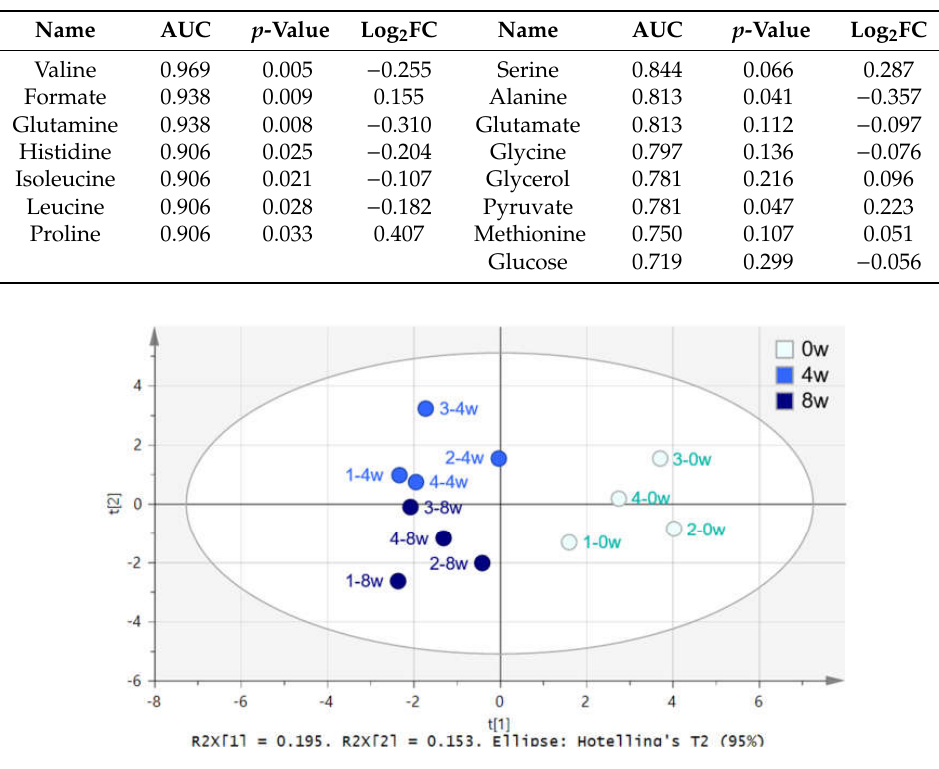
Figure 4. PLS-DA score plot of dog serum 0 ( ● ), 4 ( ● ), and 8 ( ● ) weeks after feeding of black ginseng.